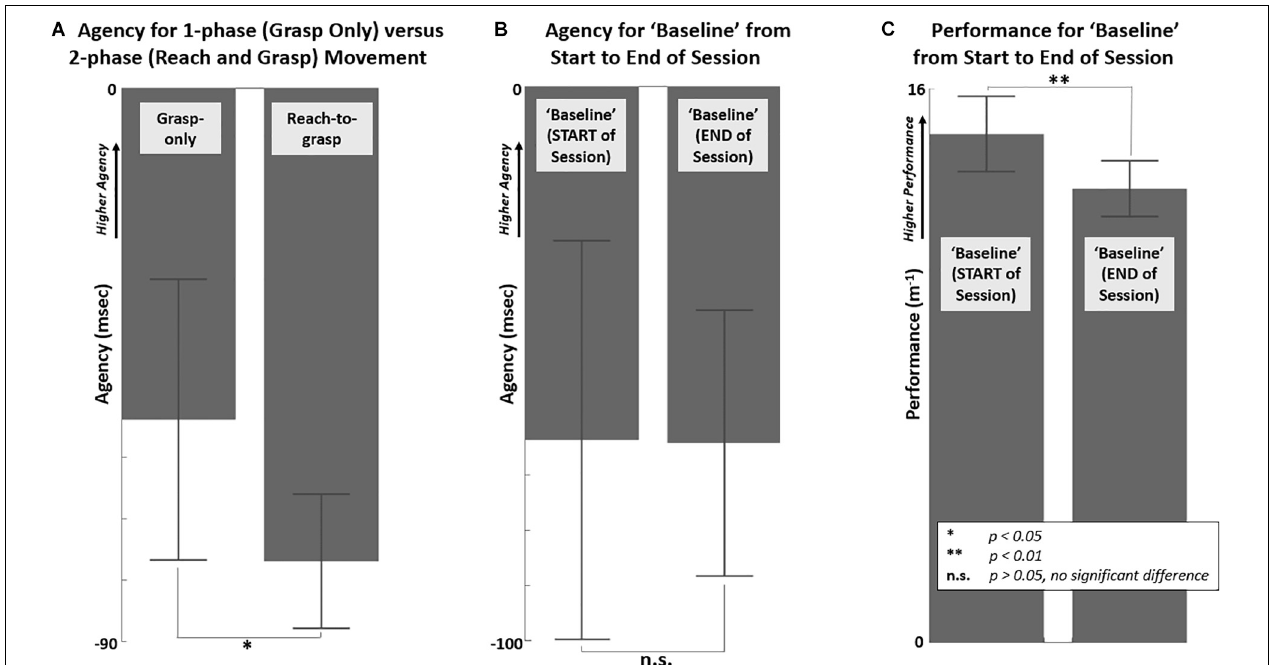
FIGURE 4 | Differences in agency and performance shown between “grasp only” and “reach and grasp” and across the session. (A) Agency for “grasp only” versus all reach-to-grasp test blocks ( p = 0.017, t -stat = 2.92), (B) Agency for “Baseline” test blocks at start versus end of session ( p = 0.96, t -stat = 0.05), (C) Performance, measured as inverse of mean path length error, for “Baseline” test blocks at start versus end of session ( p = 0.002, t -stat = 4.36).